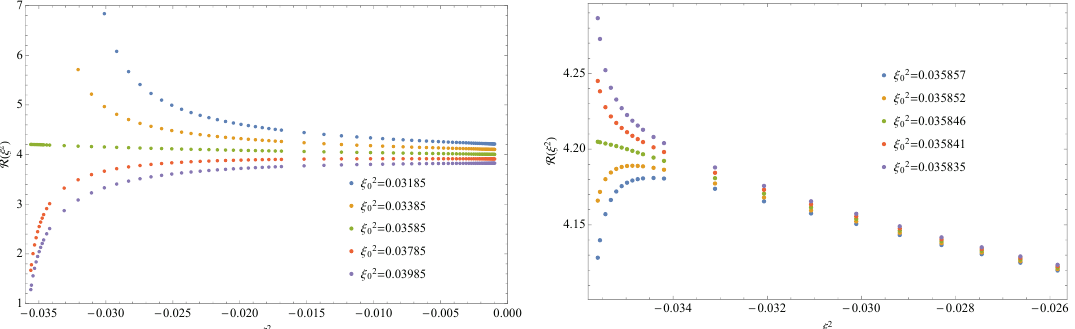
) 5 12 , with different values of ξ 2 0